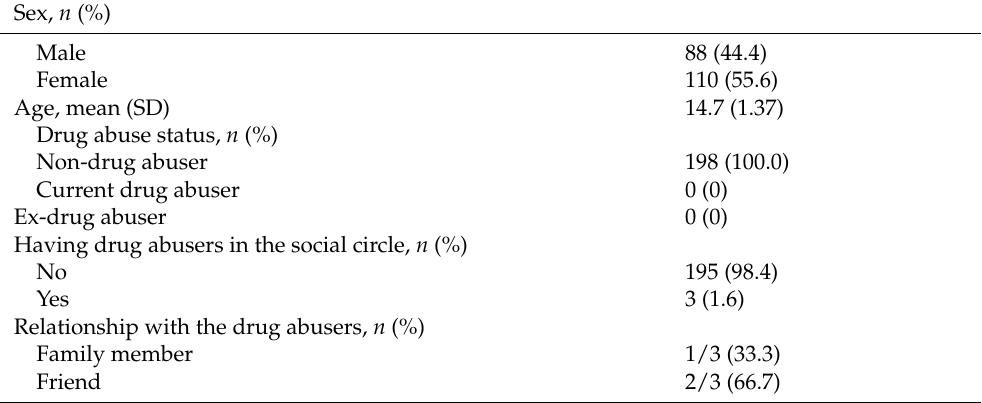
Table 1. Baseline characteristics of anti-drug ambassadors ( n =